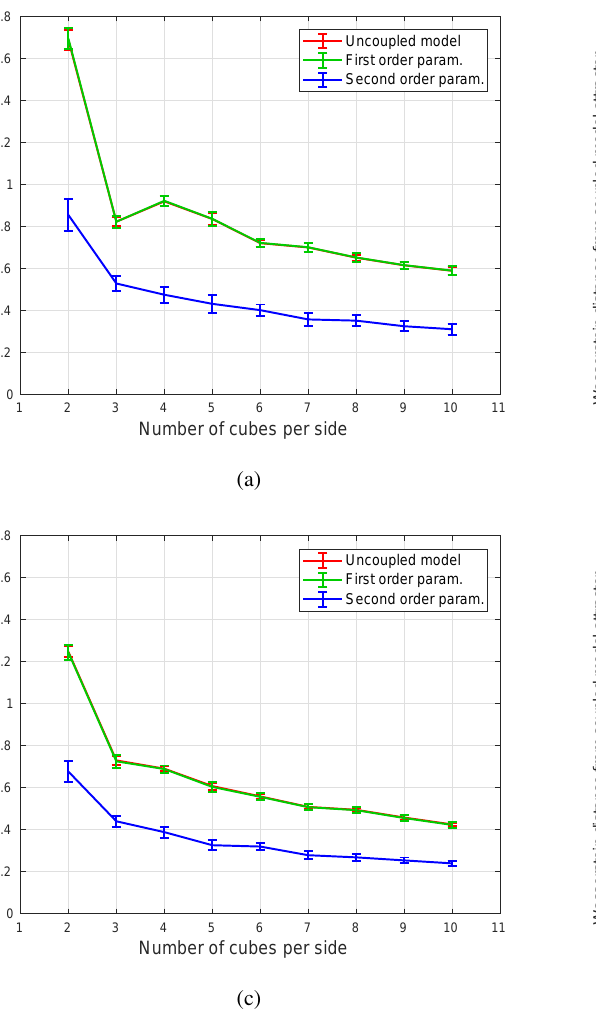
, the Lorenz 63 model acts as a slow forcing on the Lorenz 84 6